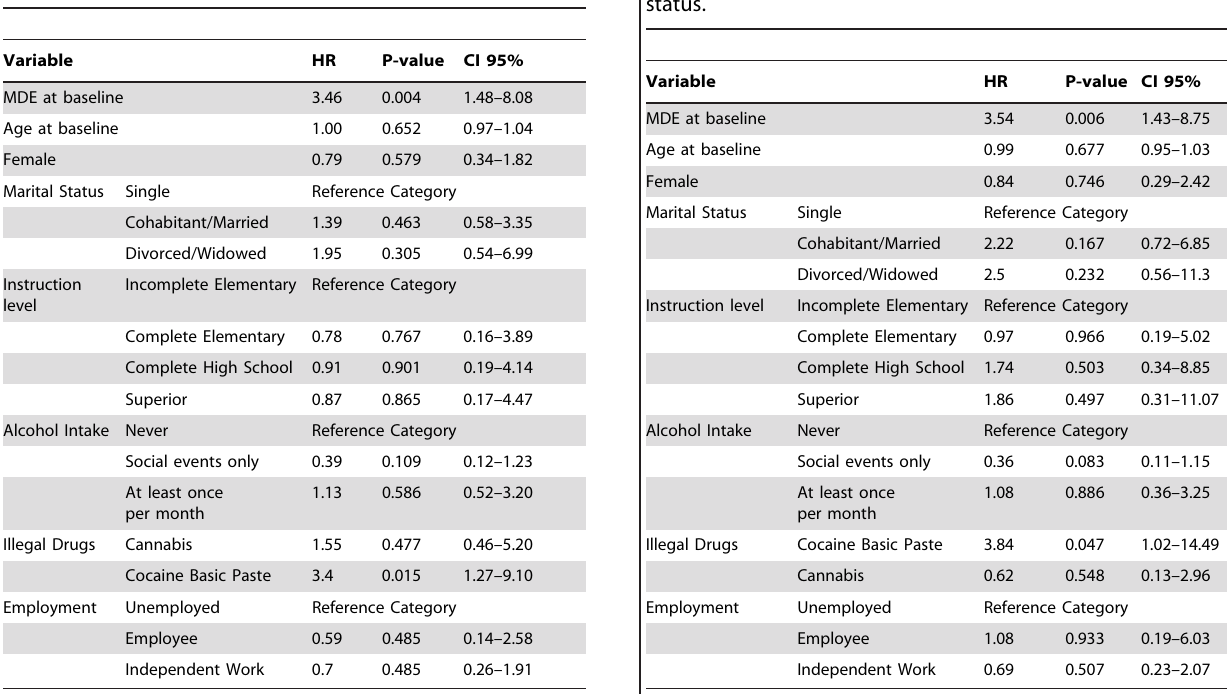
MDE at Baseline